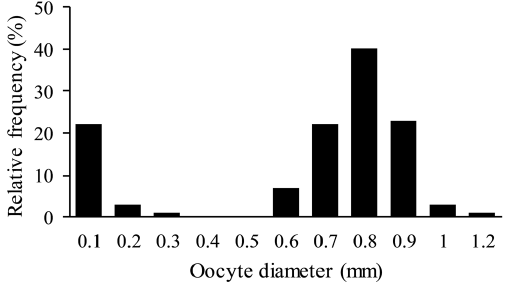
Figure 3. Oocyte size distribution from ten spawning capable ovaries of Apistogrammoides pucallpaensis